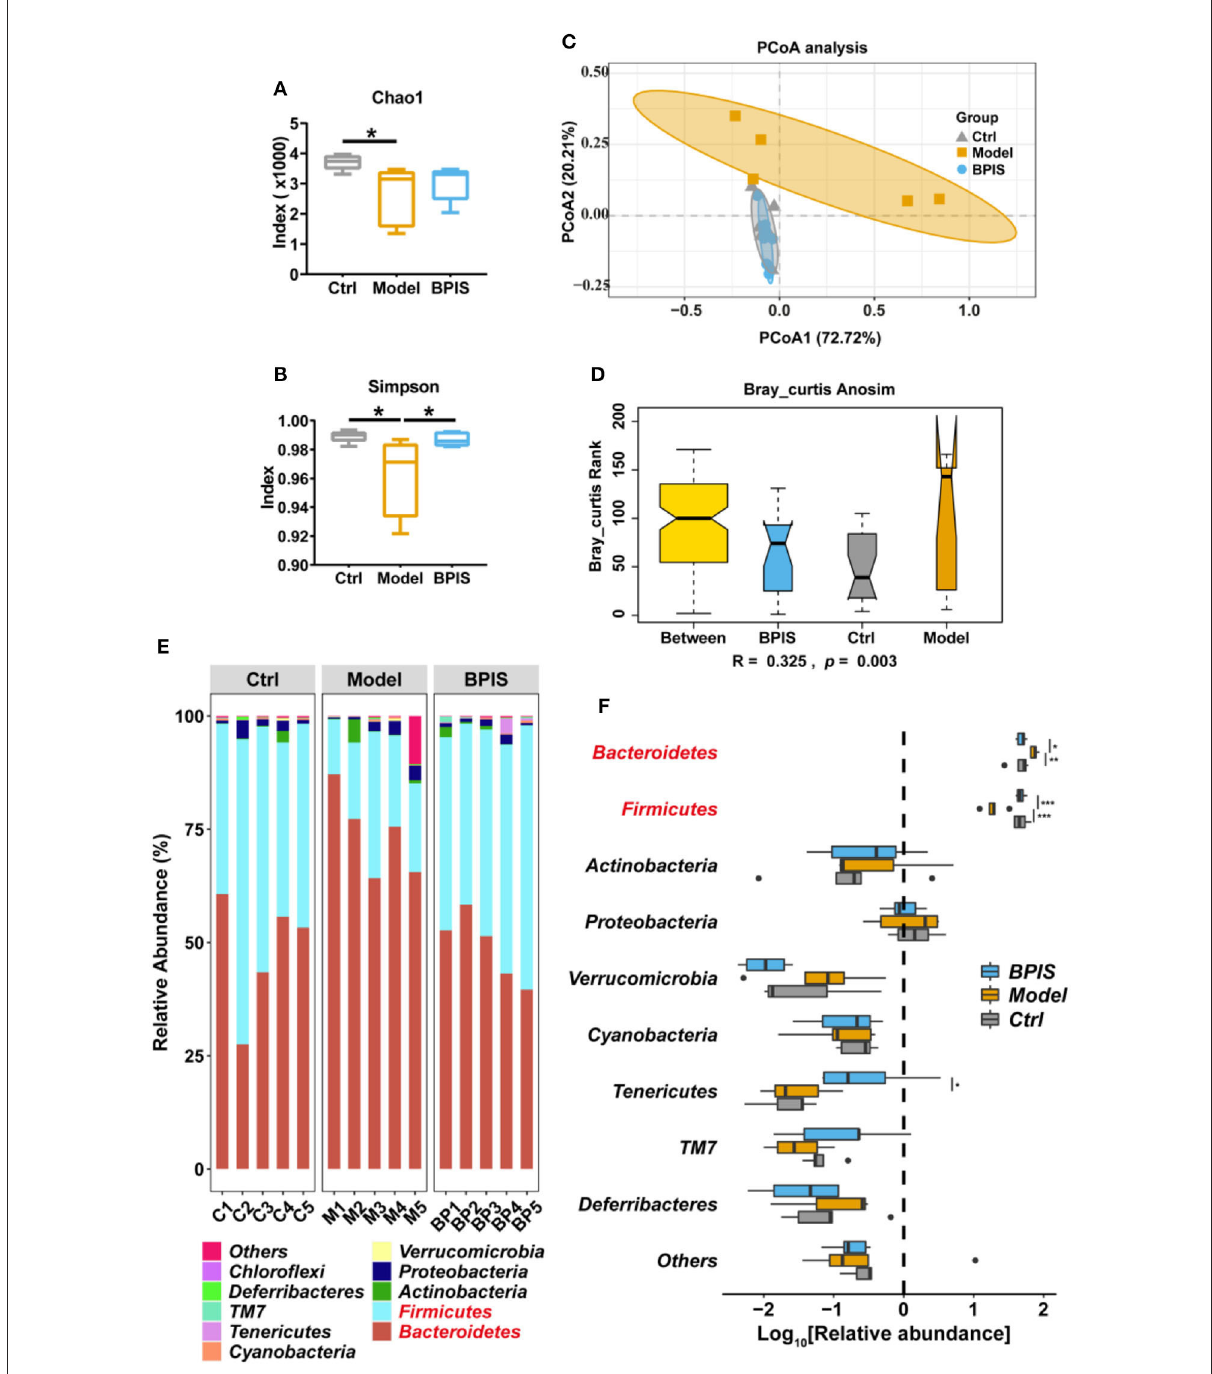
FIGURE5 BPIS increased microbial diversity and reshaped the microbial community. Stool samples from different groups were used for microbiome analysis. (A,B) Alpha diversity analysis of gut bacterial richness (A) and diversity (B) from different mouse groups. (C) Principal coordinates analysis (PCoA) plot of the gut microbiota composition from different groups. (D) Bray_curtis ANOISM analysis. Boxes are the interquartile range; median values are bands within the boxes; whiskers are 1.5 times the IQR. (E) Taxonomic distributions of the relative abundances at the phylum level. (F) Taxonomic composition indices on a log 10 scale for each phylum of fecal bacteria from mice. Data are presented as the means ± SD ( n ≥ 5) and were analyzed by an ordinary one-way ANOVA with Tukey’s multiple comparisons. * p < 0.05, ** p < 0.01, *** p <